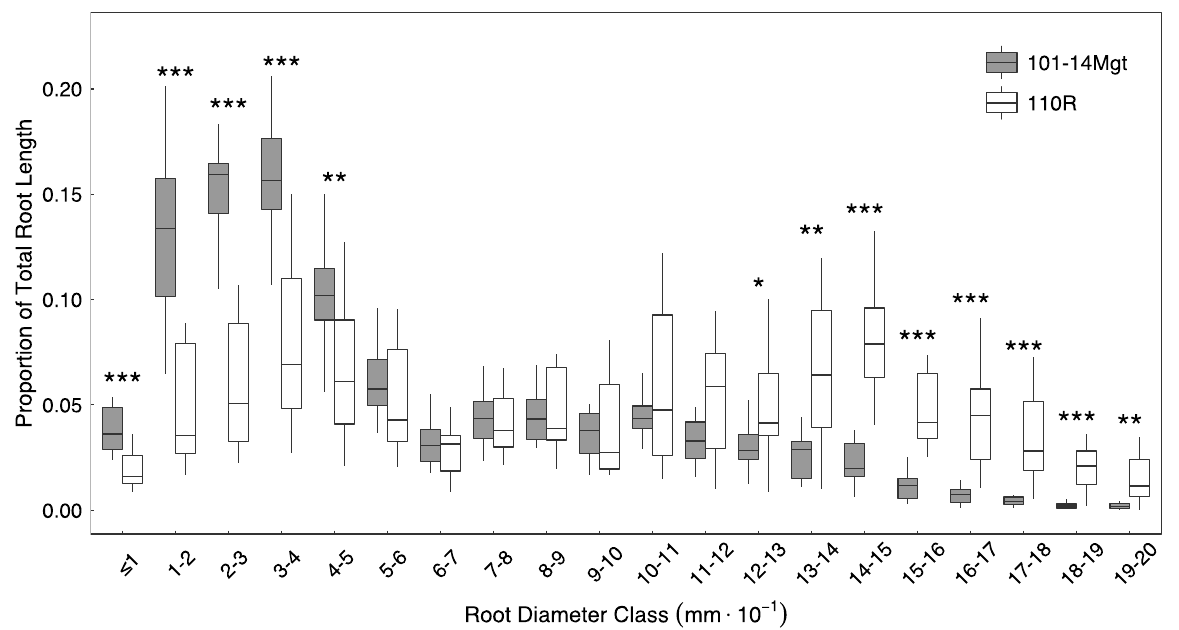
Figure 1. Root distributions by diameter class in 101-14Mgt and 110R root systems grown from herbaceous cuttings in the greenhouse ( n = 15). Boxes represent first and third quartiles; whiskers represent samples within 1.5 times the interquartile range. Although included in statistical analyses, outliers are not displayed. Asterisks indicate significant differences between rootstocks at each diameter class as determined by Welch’s t -test. p < 0.05 = *; p < 0.01 = **; p < 0.001 = ***.